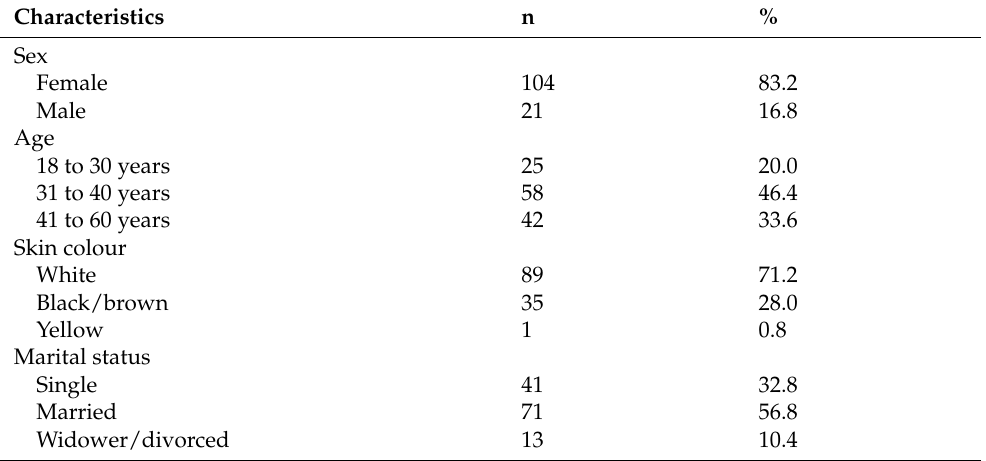
Table 1. Personal and occupational characteristics of participants in the HEROES cohort (n = 125).